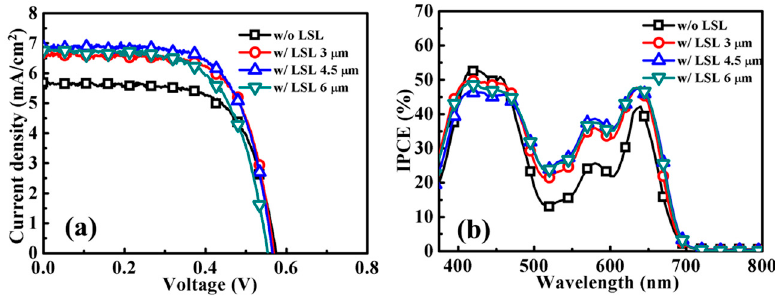
Figure 6. ( a ) J–V curves and ( b ) IPCE spectra of YD2-o-C8-TBA-sensitized ZnO DSSCs fabricated using 5- μ m-thick ZnO anodes with light-scattering layers (LSL) of various thicknesses.